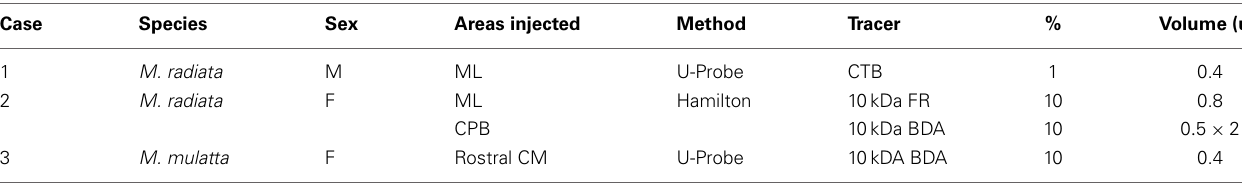
Table 1 | Experimental details for each